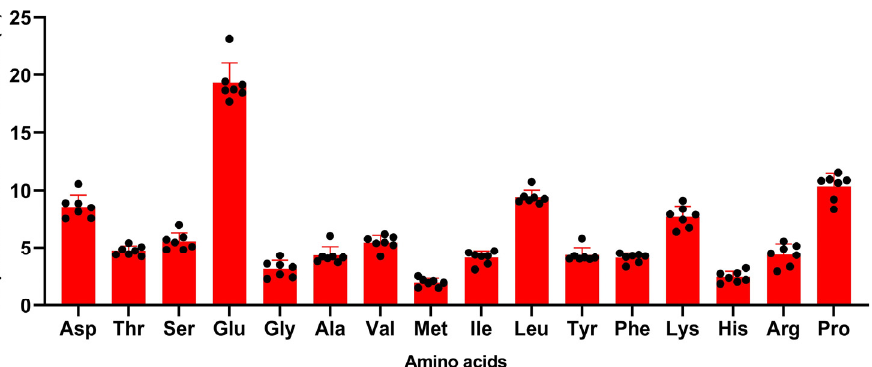
Figure 1. Amino acid profile of sow milk across studies (% of total amino acids, the black spot were